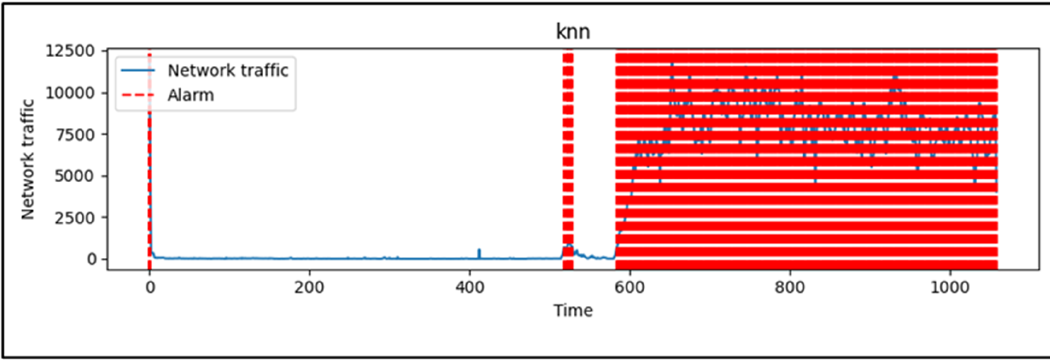
Figure 16. Flooding attack detection by KNN.